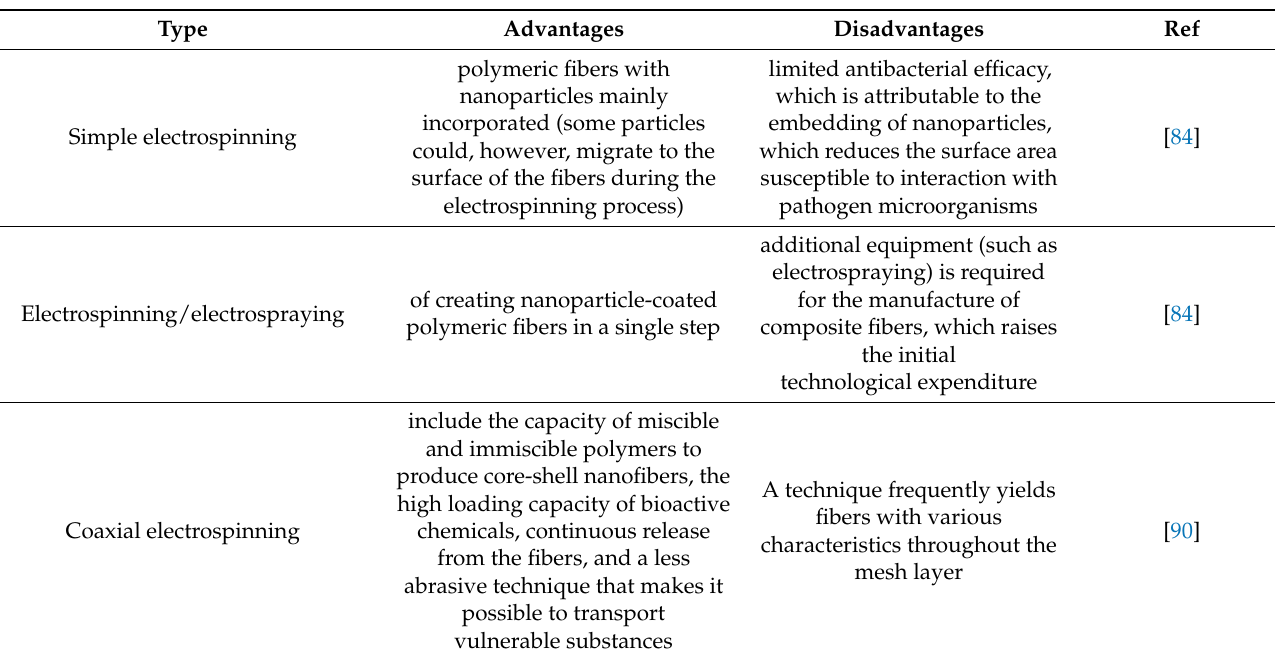
Table 1. Advantages and disadvantages of different approaches for designing fibrous composite materials by